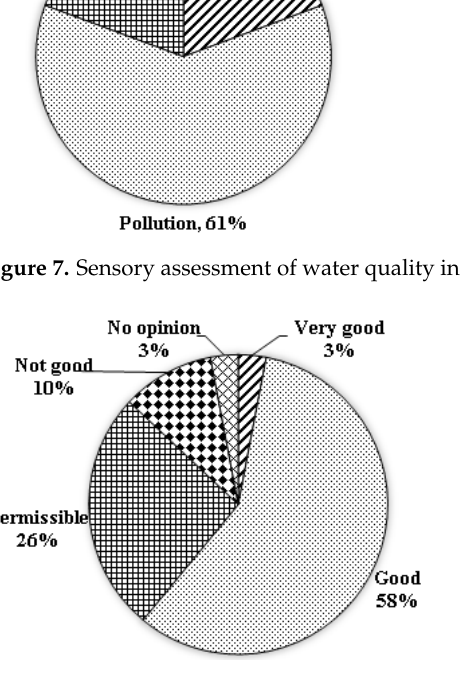
Figure 8. Interview results on the quality of irrigation systems in LNHNR.